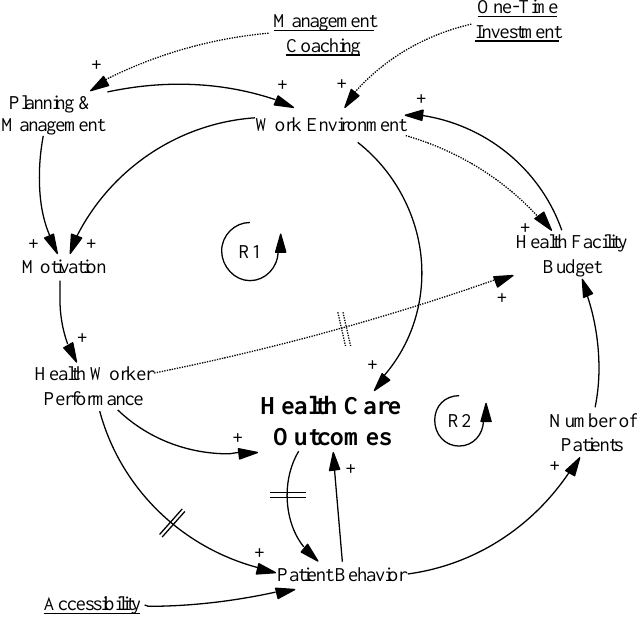
Figure 5. Causal loop diagram of “success to the successful” hypothesis.